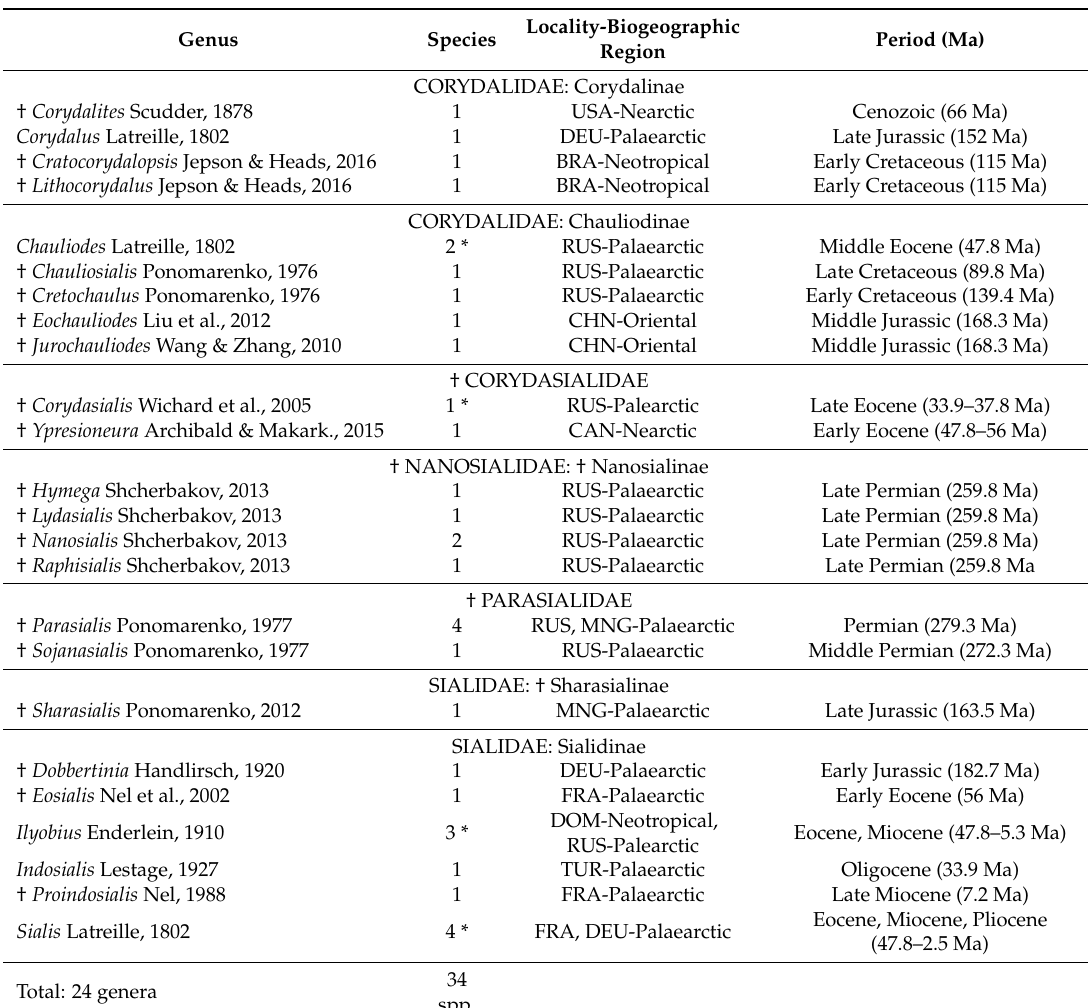
Table 2. Genera of Megaloptera with extinct valid species (BRA = Brazil, CAN = Canada, CHN = China, DEU = Germany, DOM = Dominican Republic, FRA = France, MNG = Mongolia, RUS = Russia, TUR = Turkey, USA = United States; * = some species from amber deposits; †: extinct